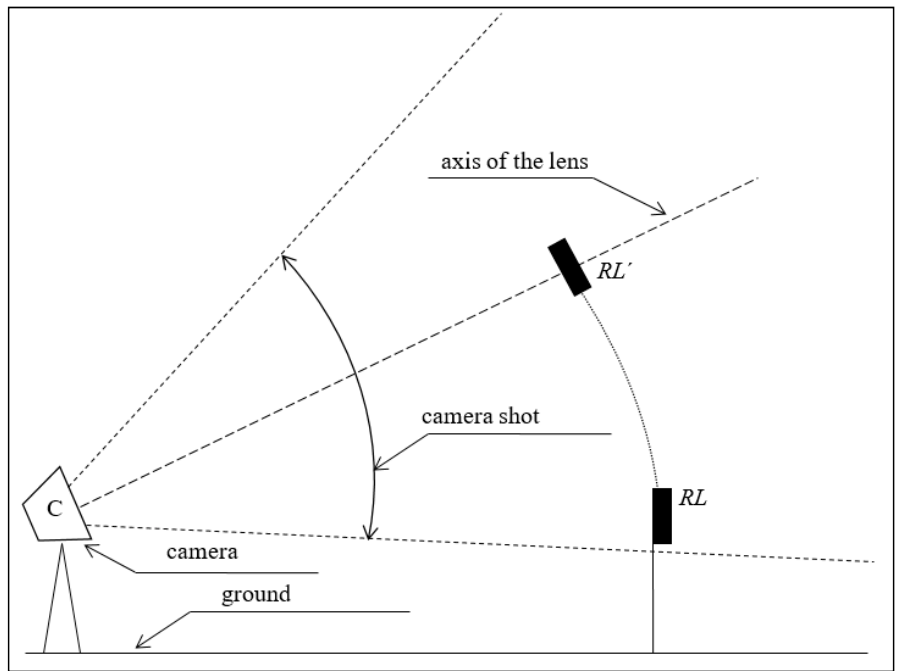
Figure 6. The basic scheme for the measurement of the parachute vertical using the photo-optical method—side view (source: The authors of this article).